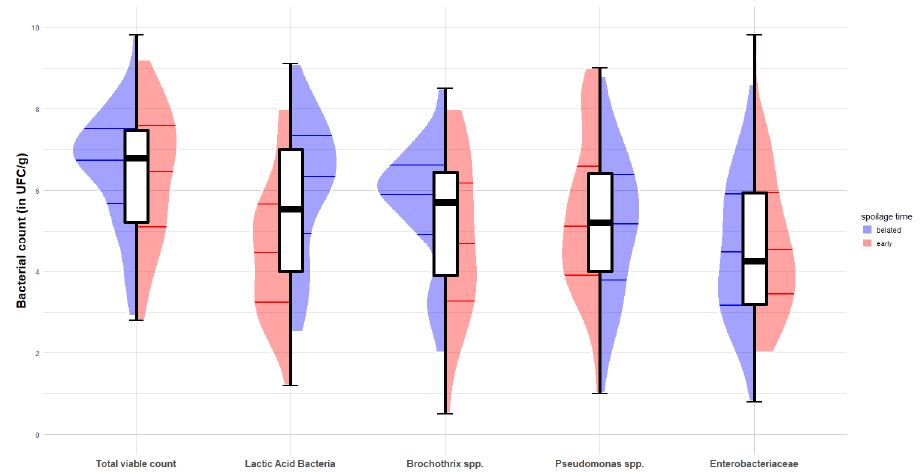
Figure 8. Distribution of bacterial count observed at spoilage occurrence time for different microbiological indicators in early and belated spoilage stages. The different plots correspond to different indicators. For each indicator, the central boxplot represents the overall distribution of the bacterial count. Half violin plots in red (or blue) represent the distribution of the bacterial count at the spoilage occurrence time in the cases of early (or belated) spoilage. Horizontal thick lines on half violin plots correspond to the first quartile, median value and third quartile of each distribution, respectively.